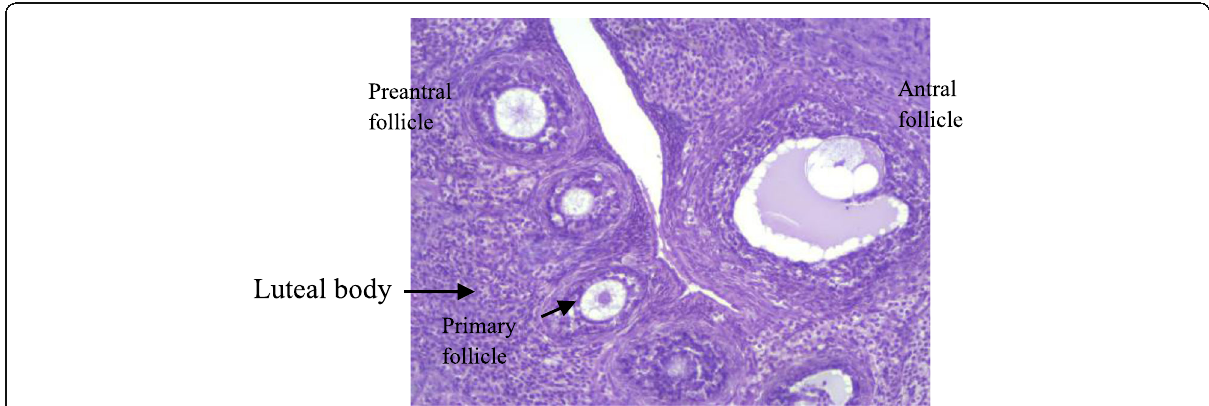
Fig. 4 Cross-section of rat ovary in the extract group, dose 500 mg/kg (× 100, H&E). The cysts disappeared and the number of luteal bodies and follicles in different stages increased